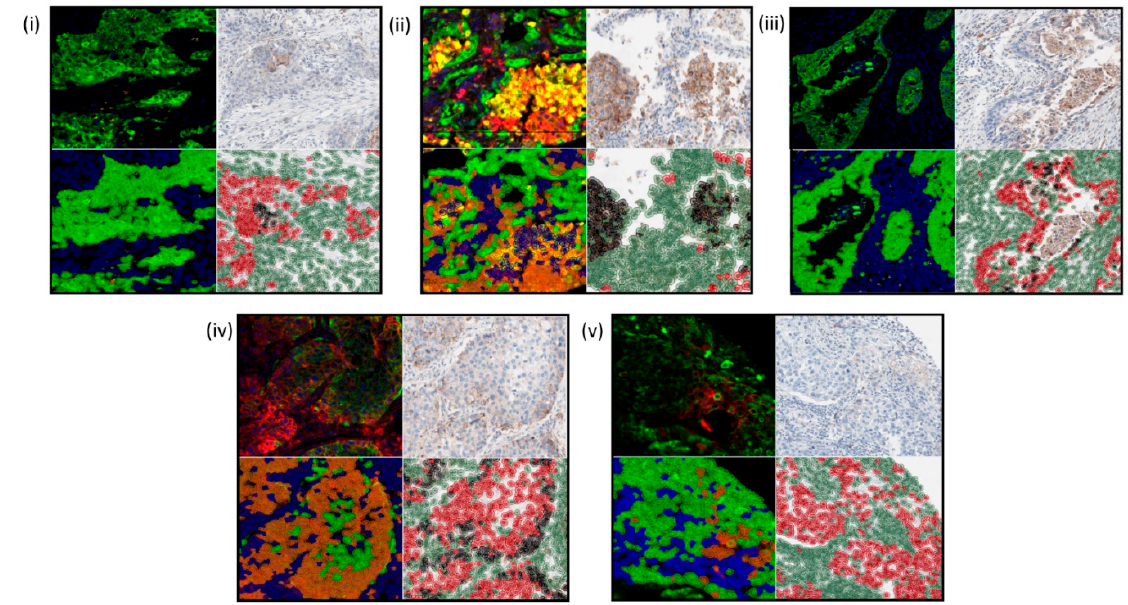
Figure 5. Reasons for discordance. These were due to several factors. ( i ) Classifier inaccuracy on the DAB slide, ( ii ) macrophage infiltration in both image types, ( iii ) spurious staining in both image types, ( iv ) threshold sensitivity in both image types, ( v ) sensitivity of cell identification in the mIF.